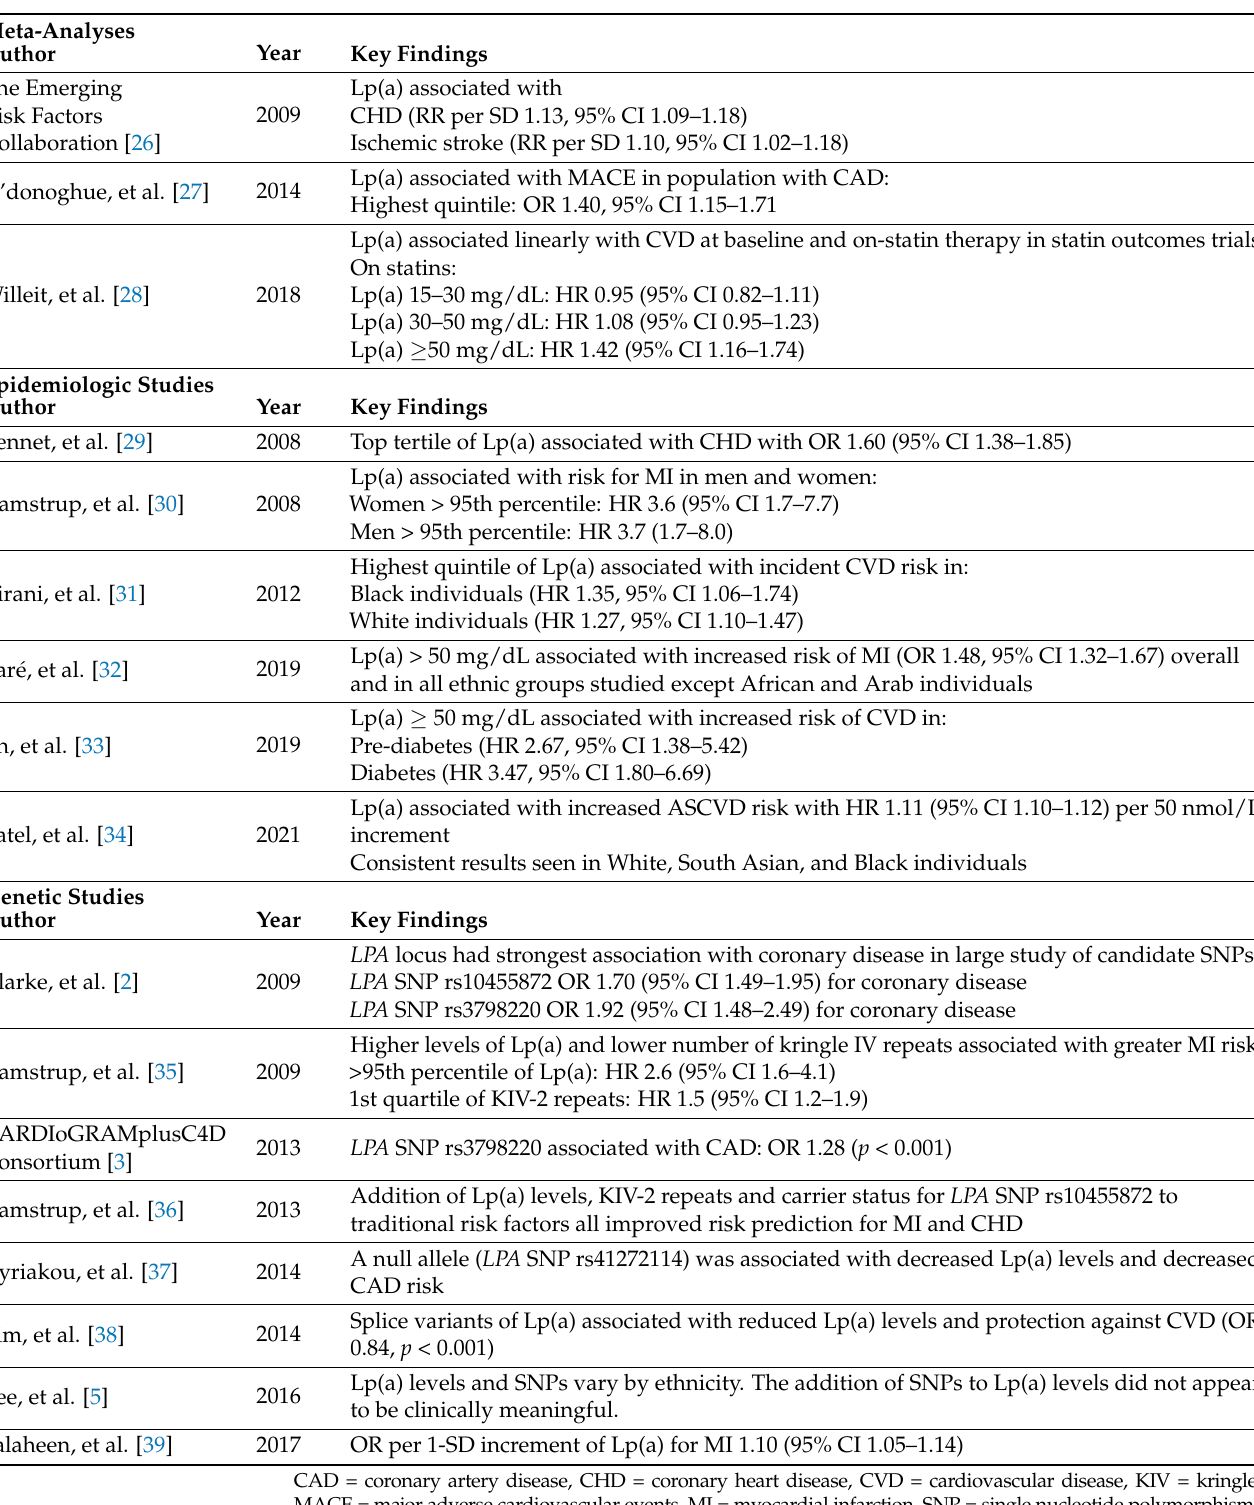
Table 1. Key studies of Lp(a) as a risk factor for